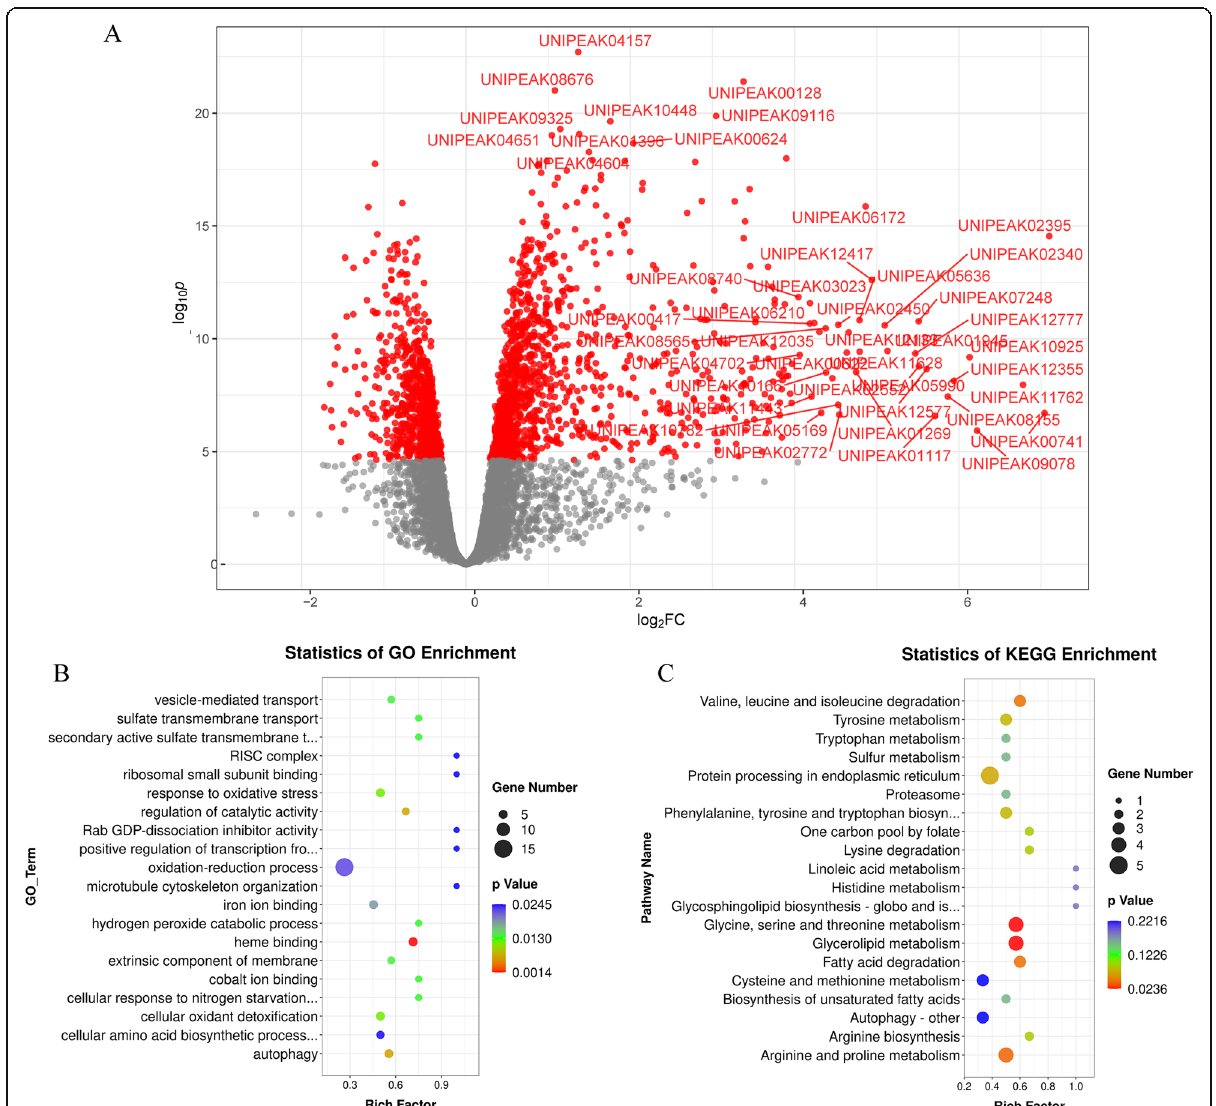
Fig. 5 Gene ontology and Kyoto Encyclopedia of Genes and Genomes analyses of coding genes containing differentially enriched m 6 A hcpeaks in cv. NIP_CK vs. cv. NIP_Cd. ( A ) Volcano plot showing logFC against statistical significance. Hcpeaks with FDR < 0.05 are coloured red with select points at the extremities of the plot labelled for easier visualisation (top 10 DE peaks or logFC < -4 or logFC > 4) ( B ) Major gene ontology terms were significantly enriched for these genes. ( C ) Major Kyoto Encyclopedia terms were significantly enriched for these